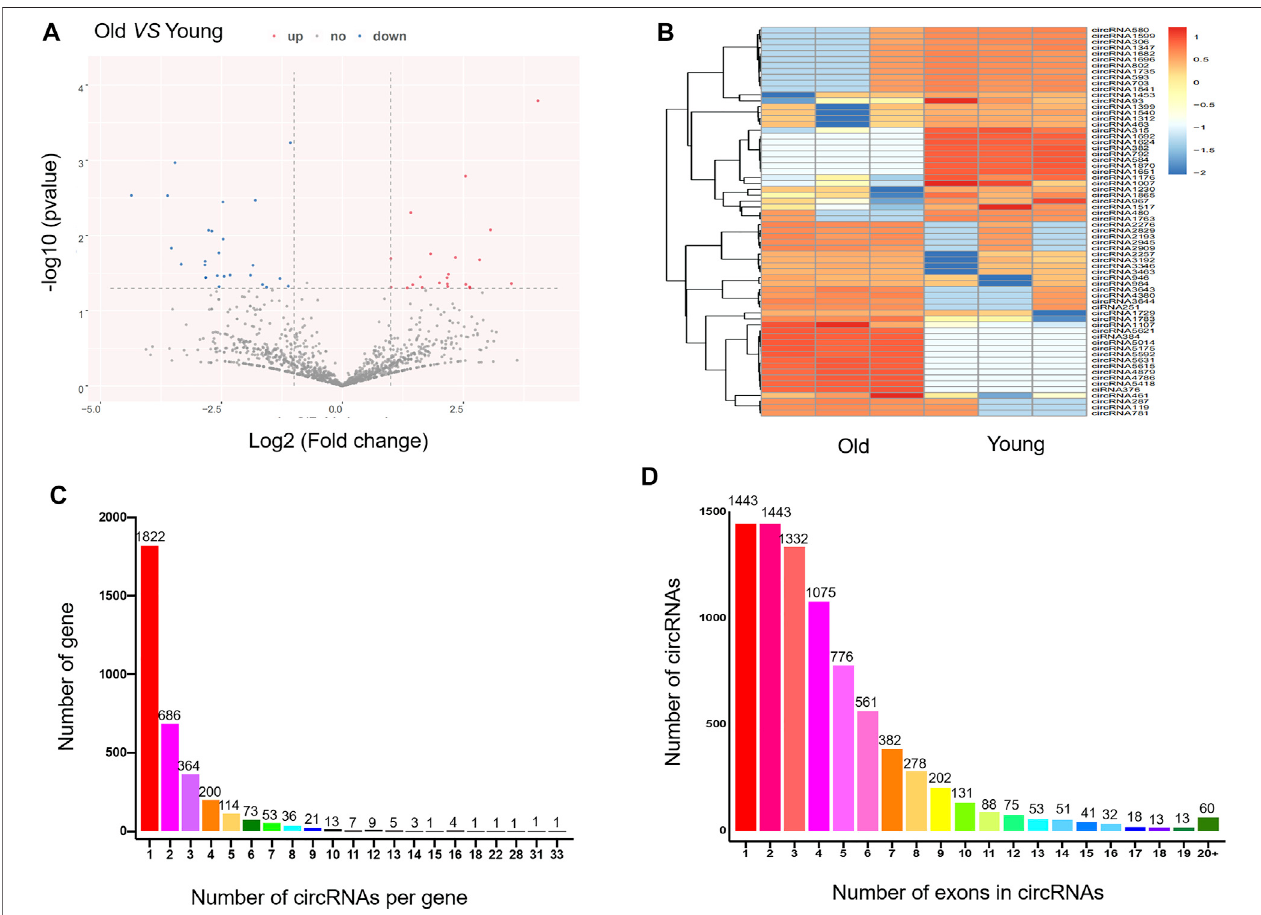
FIGURE2| Expressionpro fi leofcircRNAsinadiposetissueinyoungandoldrats. (A) ThevolcanoplotforthedifferentiallyexpressedcircRNAs.Inthevolcanoplot, the X -axis represents fold-change (log2) and Y -axis represents P (- log 10). Red points (fold change ≥ 2) indicate up-regulated circRNAs, blue points (fold change ≤ 2) indicate down-regulated circRNAs. (B) The heatmap for the differentially expressed circRNAs. In clustering analysis, up- and down-regulated genes are colored in red and blue, respectively. (C) The number of circRNAs per gene. (D) The number of exons in